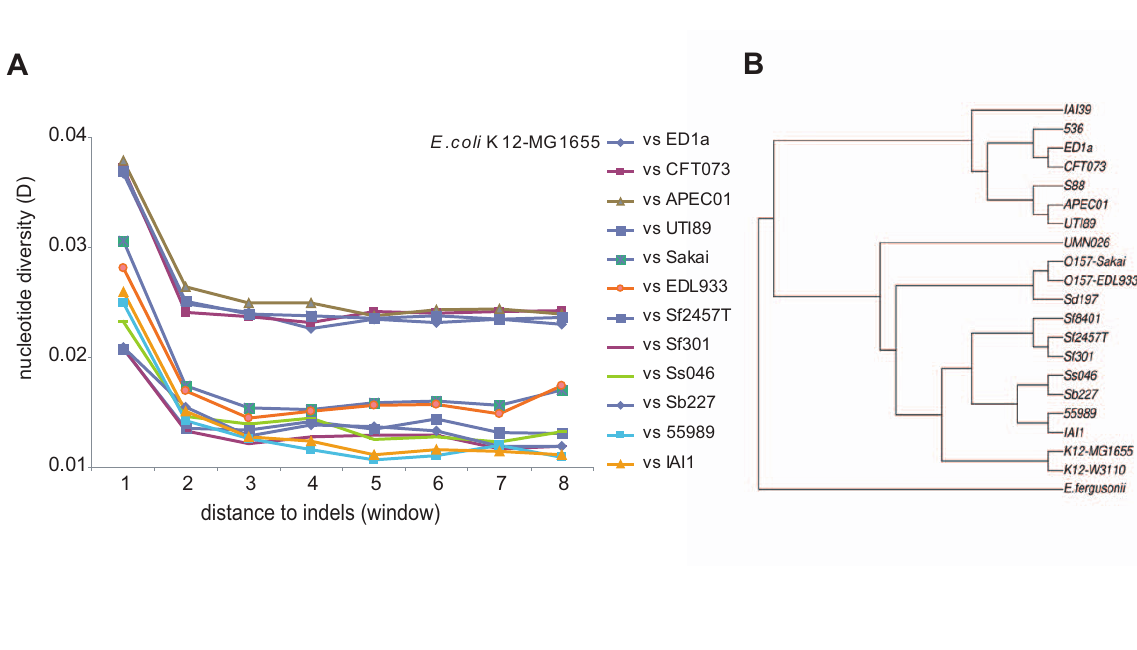
Figure 1. Nucleotide diversity increases with proximity to indels. (A) Twelve pairwise alignments between E. coli K12 MG1655 and other E. coli genomes are shown. Each number on the x -axis refers to a sequence window of defined size (Figure S1). The legend lists the comparisons in descending order of values of D for sequence window 1. A further six pairwise comparisons were omitted from this figure for clarity (see Table S4). (B) A phylogenetic tree constructed from 1,868 genes conserved in all 20 E. coli genomes used in this study as well as E. fergusonii (this phylogeny is adapted from Touchon et al., 2009 [34]).